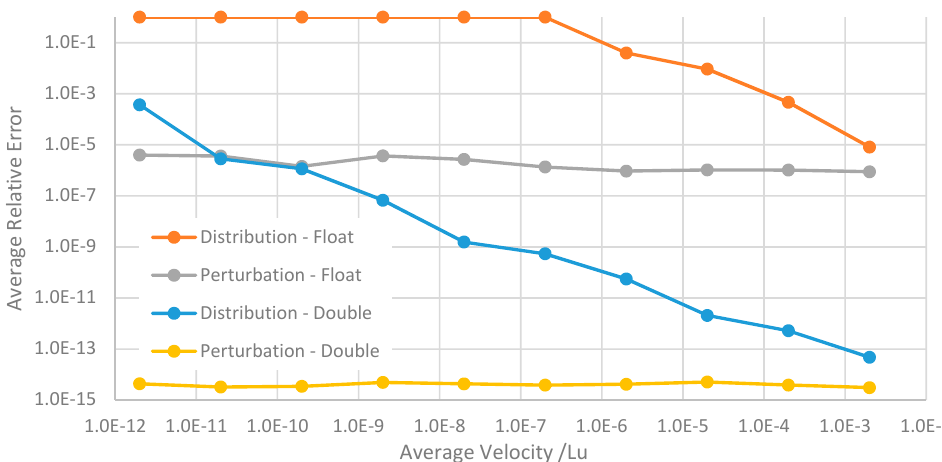
Figure 4. The average relative error of the flow profile between plates for different calculation schemes against mean flow velocity.